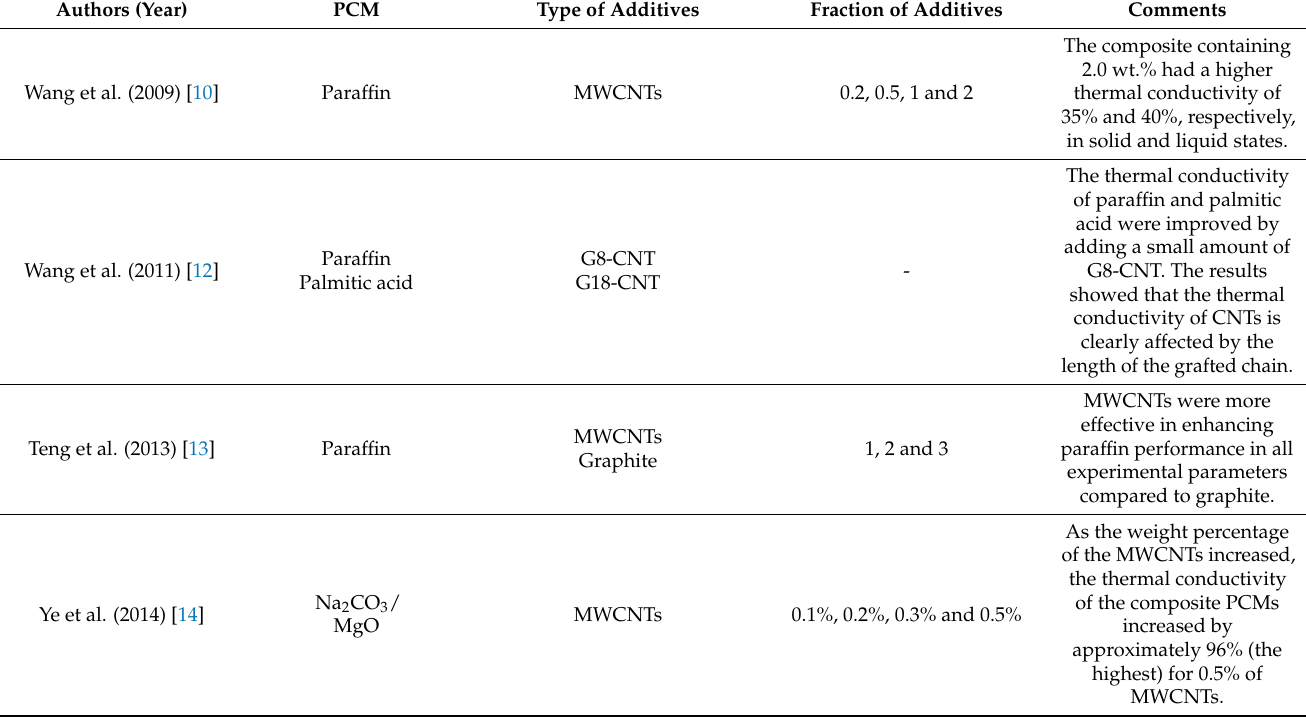
Table 5. Summary of the previous work on PCM type, nanoparticle type, and